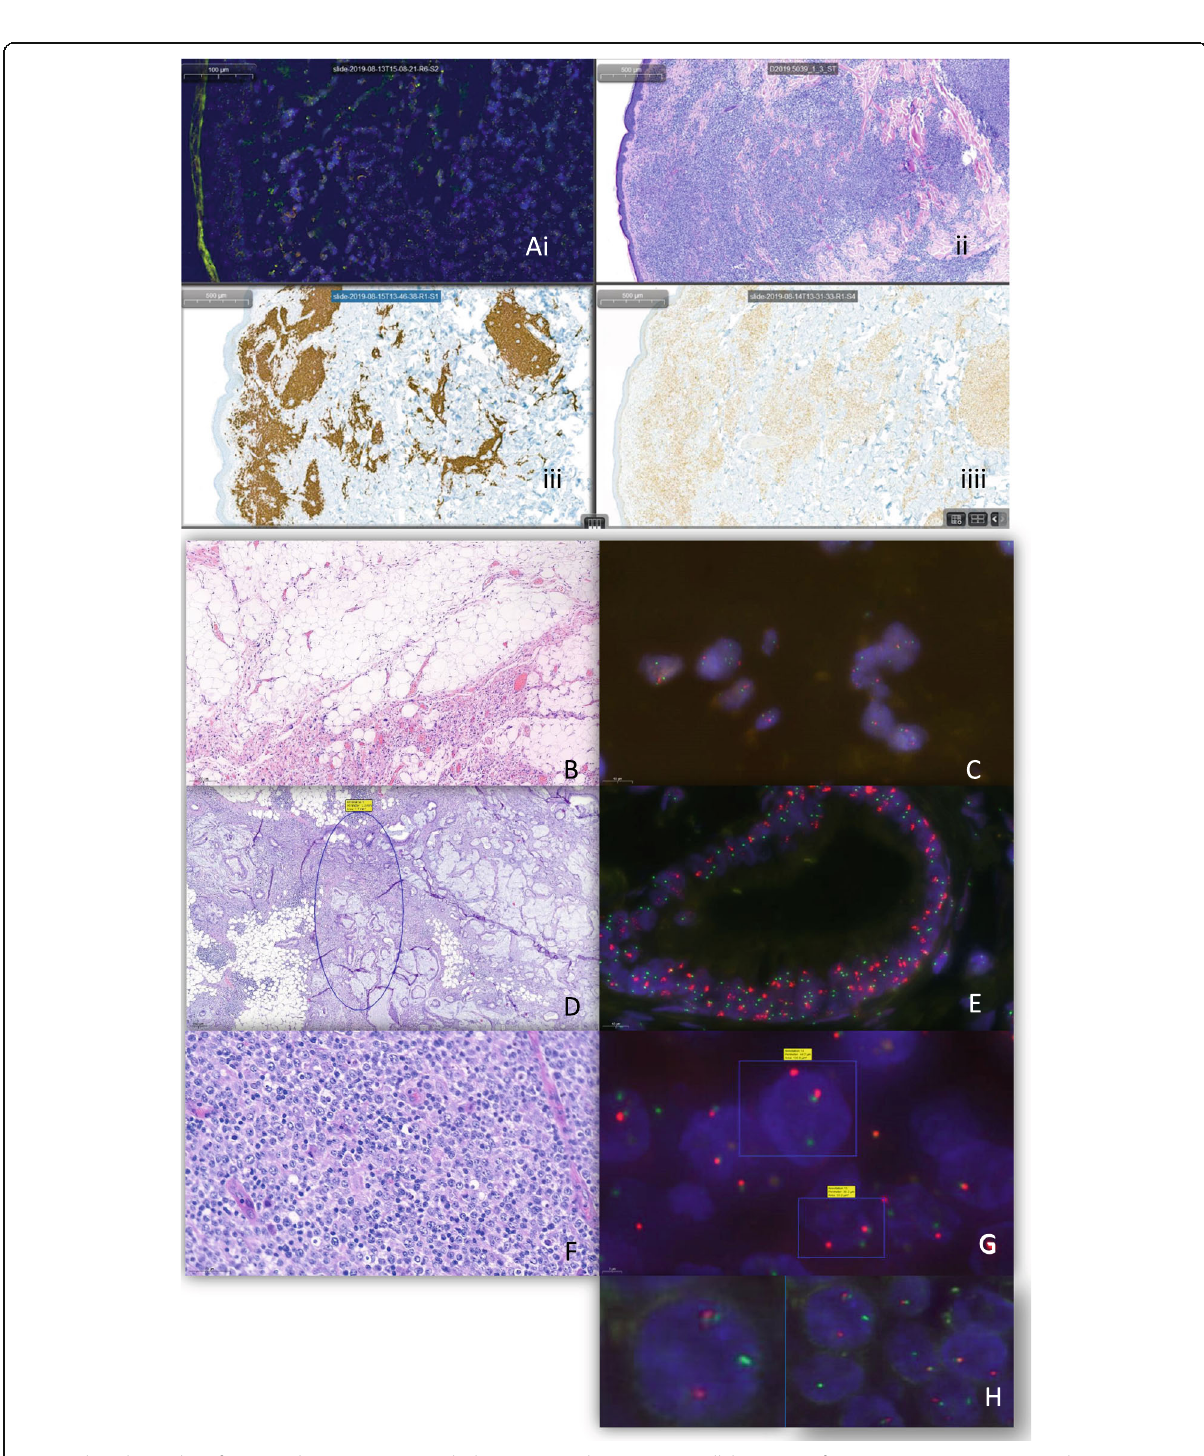
Fig. 2 Clinical samples of routine diagnostic cases with the corresponding HE: ( a ) Parallel viewing of a primary cutaneous marginal zone lymphoma: (i) BCL2 BAP probe, (ii) HE, (iii) CD20 (iiii) Bcl2; ( b , c ) Lipoma without MDM2 amplification; ( d , e ) Metastases of a cholangiocellular carcinoma showing the pre-analytical tissue selection area annotated on the CaseViewer and the corresponding MDM2 amplification; ( f , g ) “ double hit ” lymphoma with a C-MYC break in the annotated tumour cells and a break in the BCL-6 gene ( h